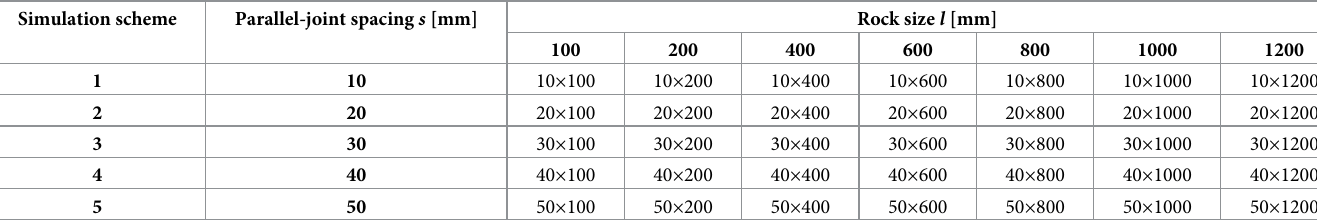
Table 1. Summary of simulation scheme and working conditions. Simulation